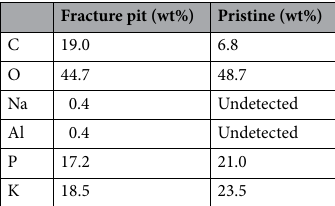
Fracture pit (wt%) Pristine (wt%)